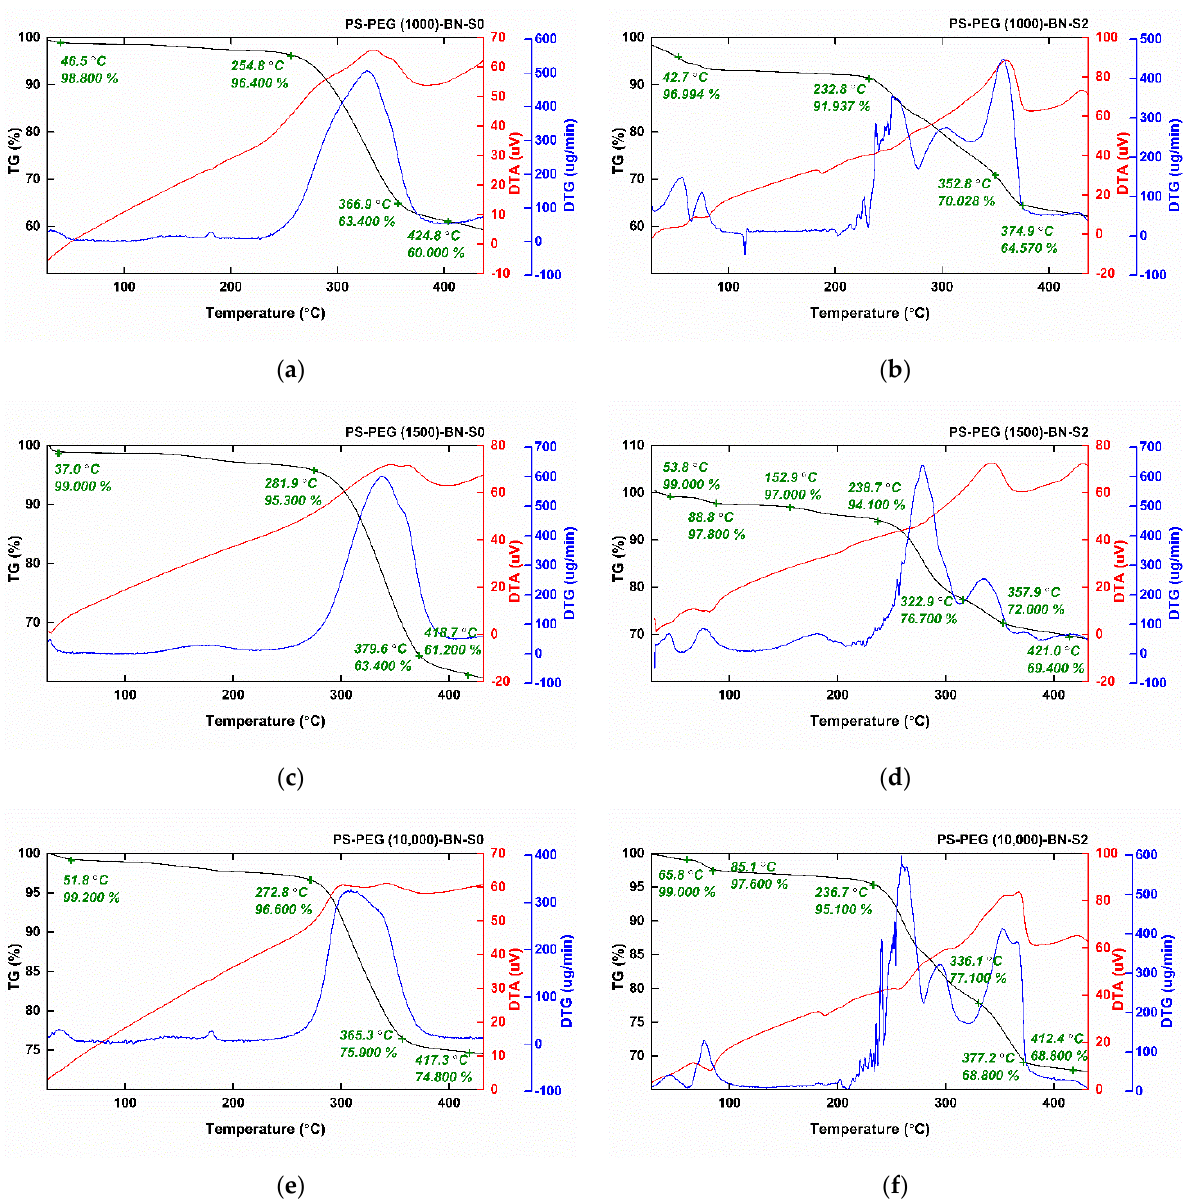
Figure 5. TGA thermograms of the PbO doped the PS-b-PEG-BN nanocomposite materials: ( a ) PS-PEG (1000)-BN-S0; ( b ) PS-PEG (1000)-BN-S2; ( c ) PS-PEG (1500)-BN-S0; ( d ) PS-PEG (1500)-BN-S2; ( e ) PS-PEG (10,000)-BN-S0; ( f ) PS-PEG (10,000)-BN-S2. Black, blue and red lines indicate the thermogravimetry (TG), derivative thermogravimetry (DTG), and differential thermal analysis (DTA) values respectively.